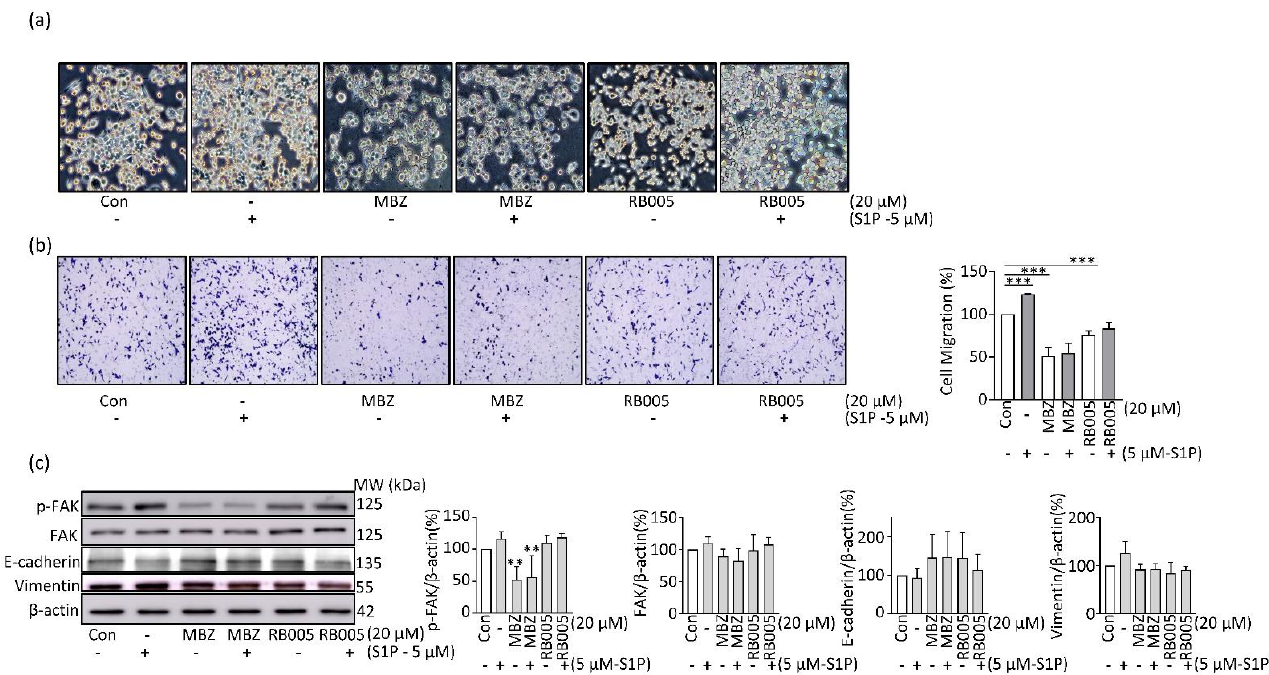
Figure 5. MBZ suppresses migration of PDAC by inhibition of S1P/FAK signaling pathway: ( a ) the MIA PaCa-2 cell treated with and without the addition of 5 µ M of S1P plus 20 µ M of each MBZ and RB005 is shown in a Phase contrast picture (10 × ); ( b ) MIA PaCa-2 cell was treated with 20 µ M of MBZ and RB005 each separately and along with the combination of 5 µ M of S1P for transwell migration assay; ( c ) evaluation of cell migration related markers by Western blotting after the protein extraction after treatment without or with 5 µ M of S1P in MBZ and RB005 treated cells. The immunoblot was repeated thrice and data was quantified by the use of ImageJ software. The data were interpreted on mean ± S.D, ** p < 0.01 and *** p < 0.001.